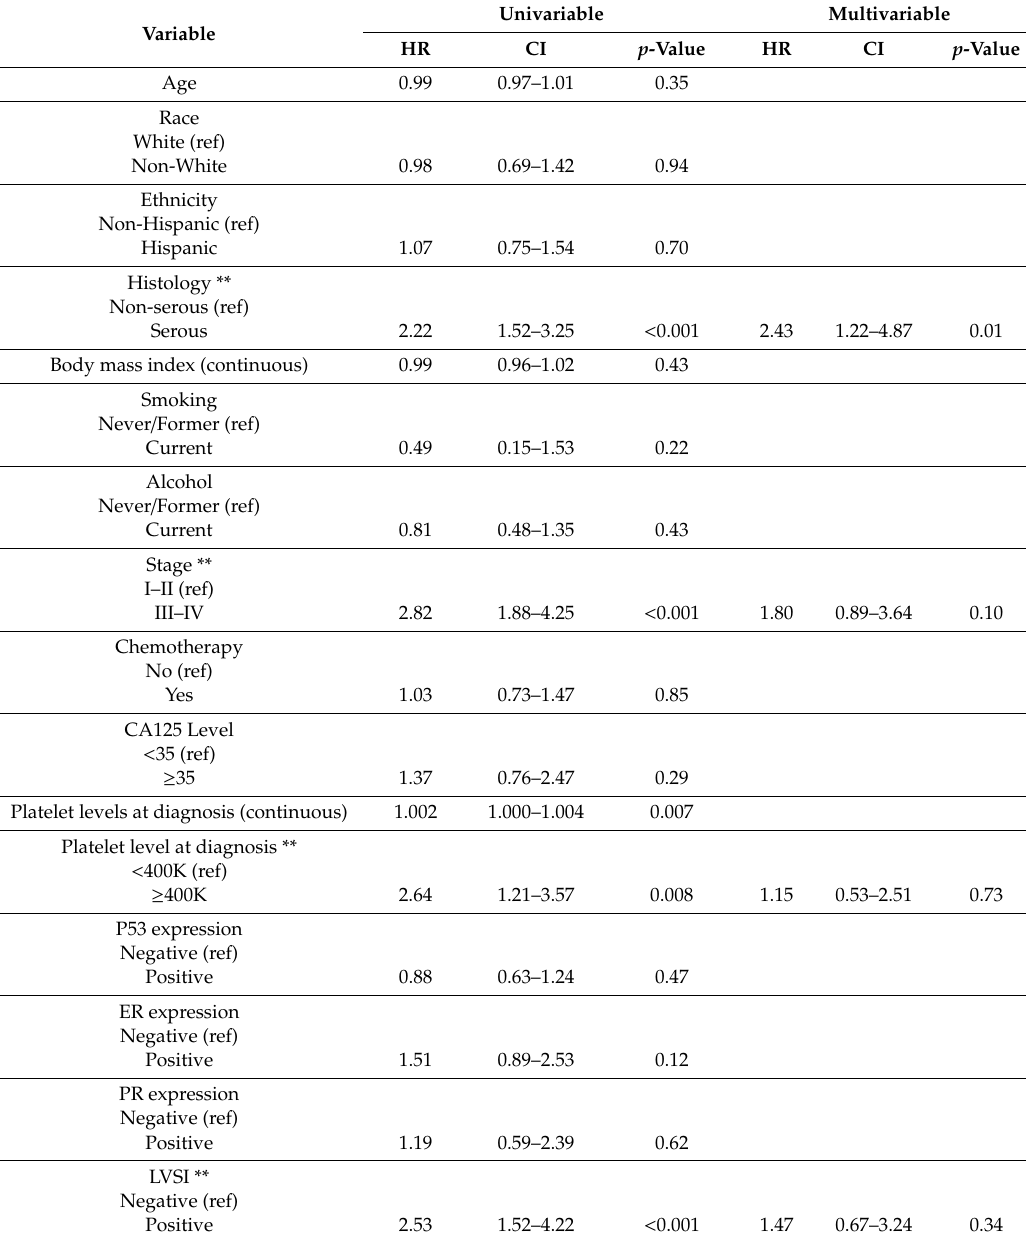
Table 2. Univariable Cox proportional hazards modeling for overall